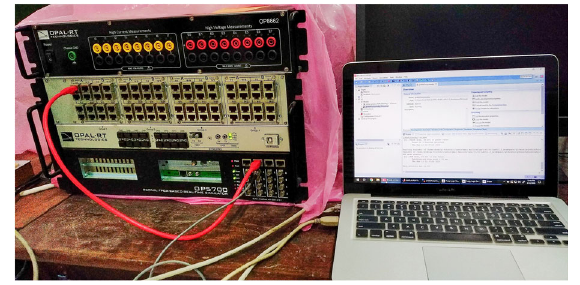
Fig. 11 OPAL-RT OP5700 RCP/HIL FPGA real-time